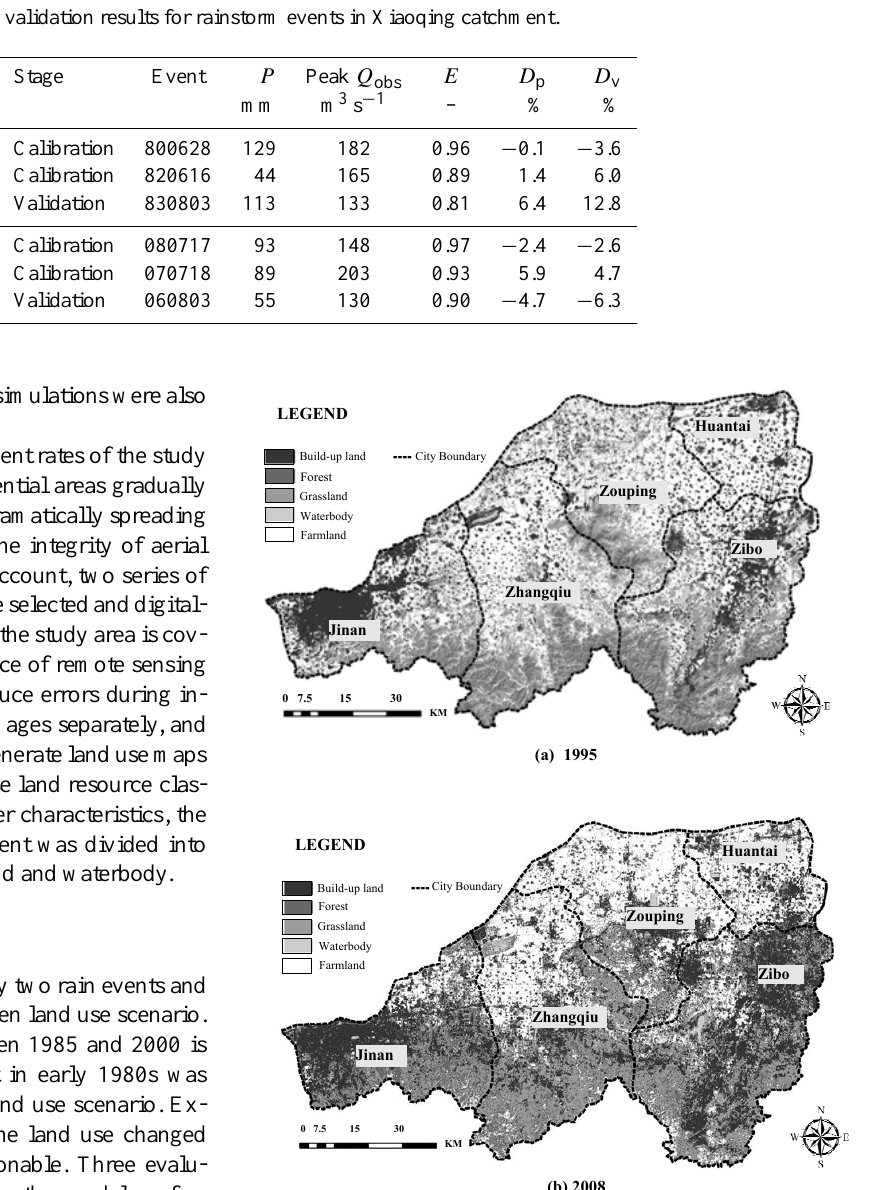
Figure 3. Land cover maps of the study catchment in (a) 1995 and (b) 2008.